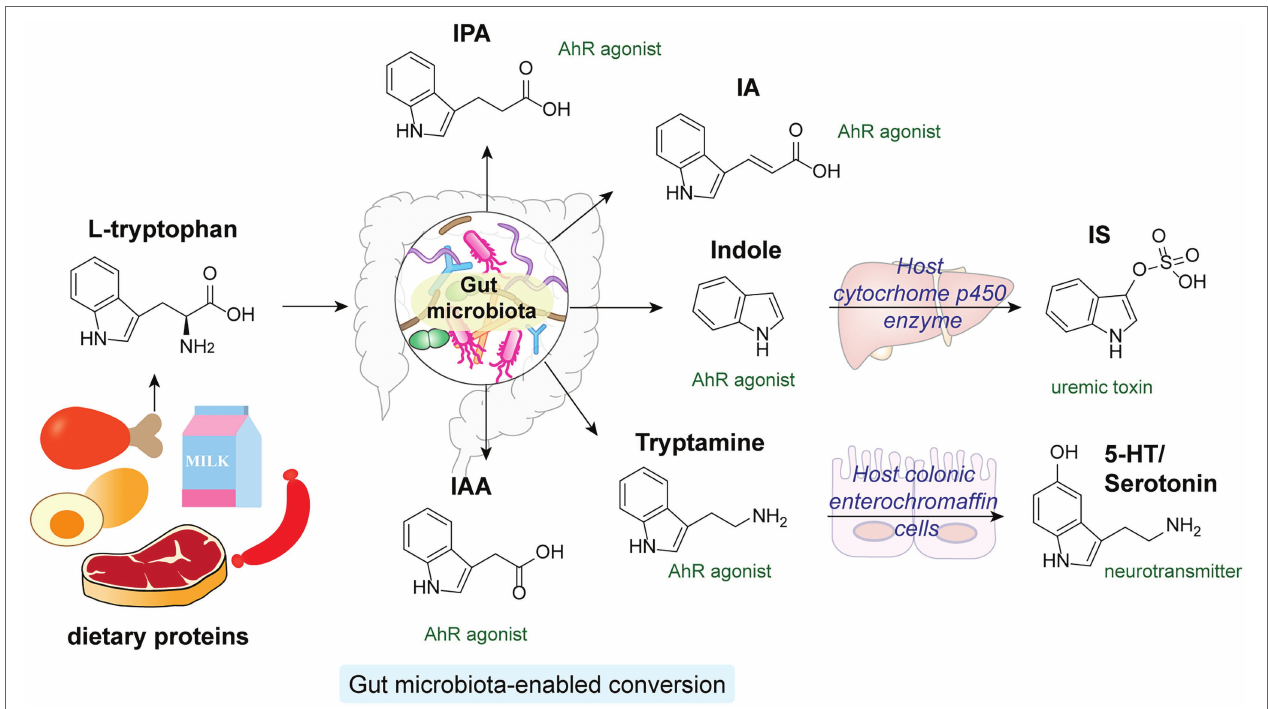
FIGURE 5 | l -tryptophan from dietary proteins is metabolized by gut microbiota into a variety of indole derivatives, which are potent AhR agonists in the